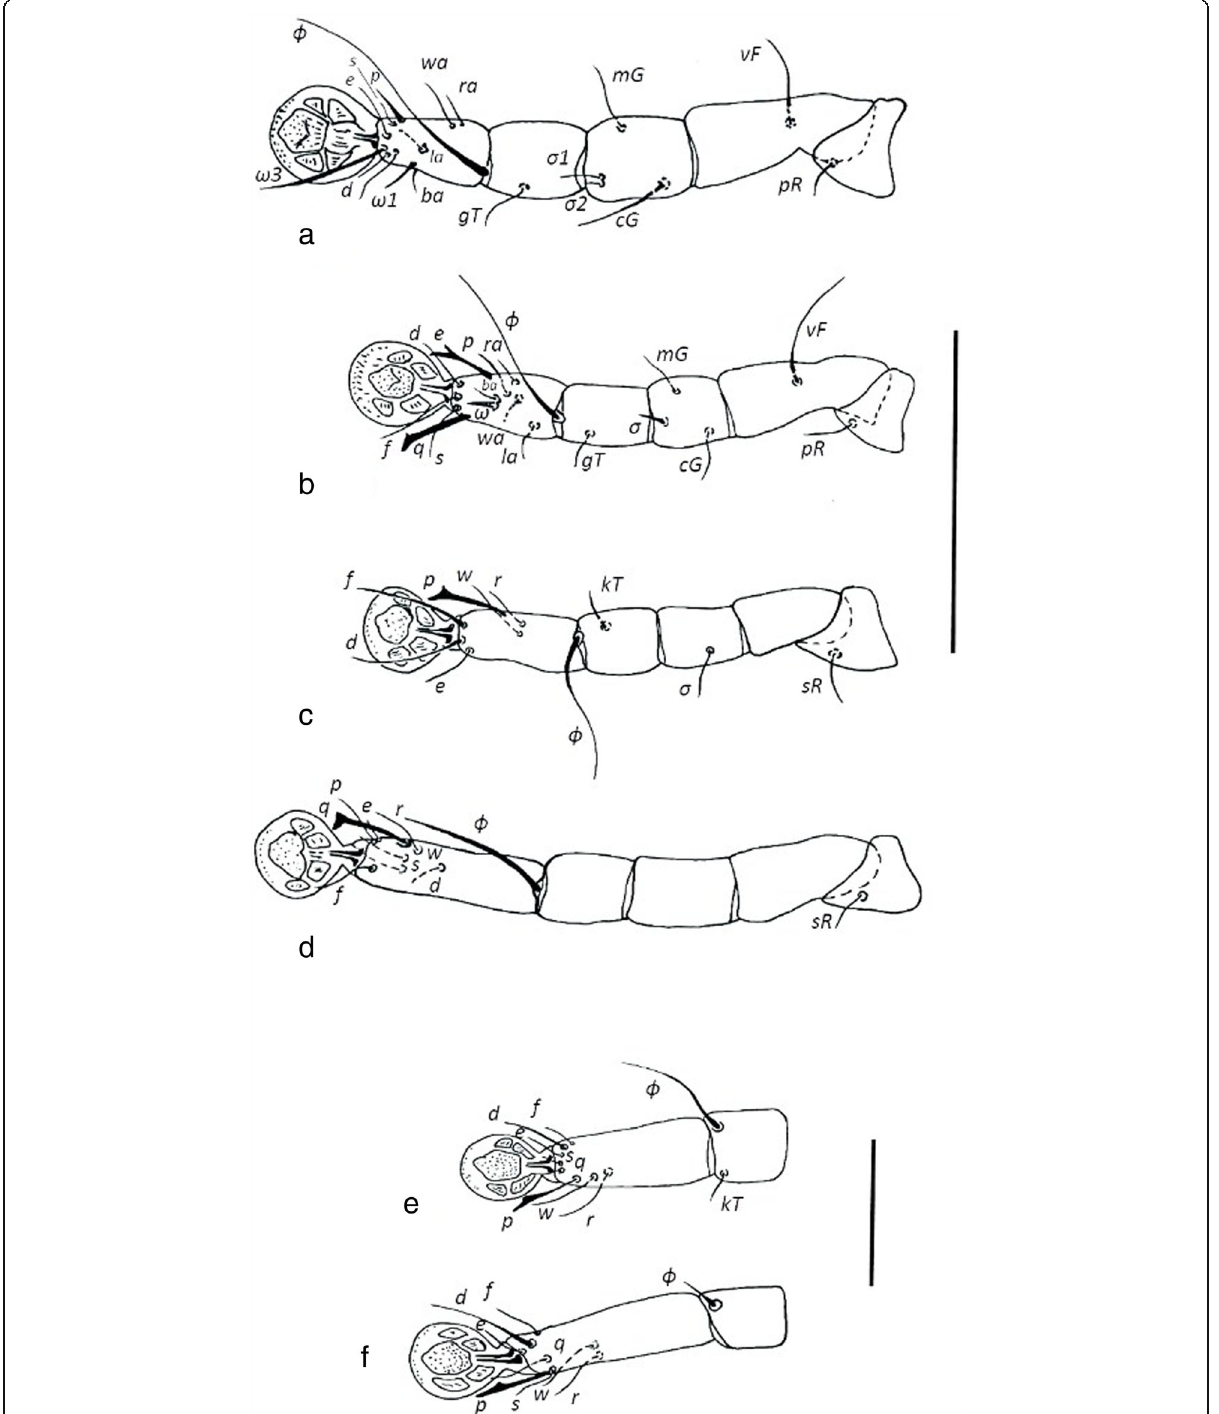
Fig. 5 Gabucinia delibata (Robin): a – d legs I – IV in male (scale bar, 100 μ m); e – f tibia and tarsus of legs III – IV in female (scale bar, 50 μ U-shaped unsclerotized area holding setae h1 , length setae: vi – vi 13, si – si 39, se – se 75. Humeral shields present. along midline 372, greatest width 215, surface punctured Setae c3 filiform, 30 long and cp 118 long. Distance be- and with polygonal reticulation anteriorly, cupules ia and tween prodorsal and hysteronotal shields 18. Hysteronotal im present. Distance between dorsal setae: c1 – d1 82, d1 – shield with anterior margin straight, posterior part with